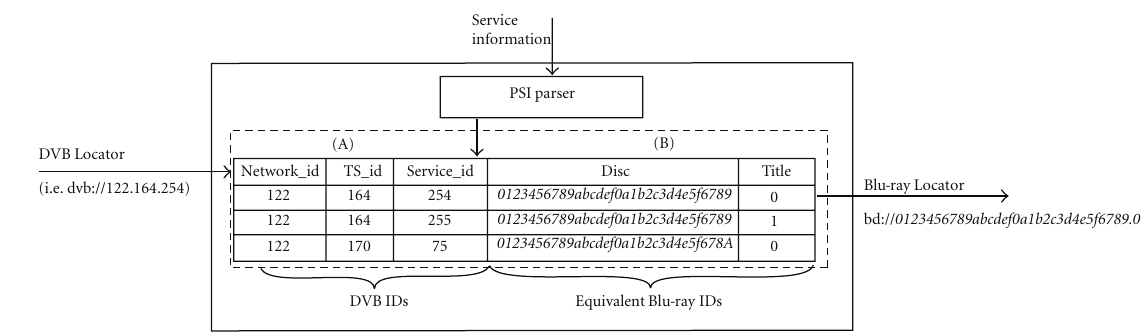
Figure 15: Locator transcoder mapping table.